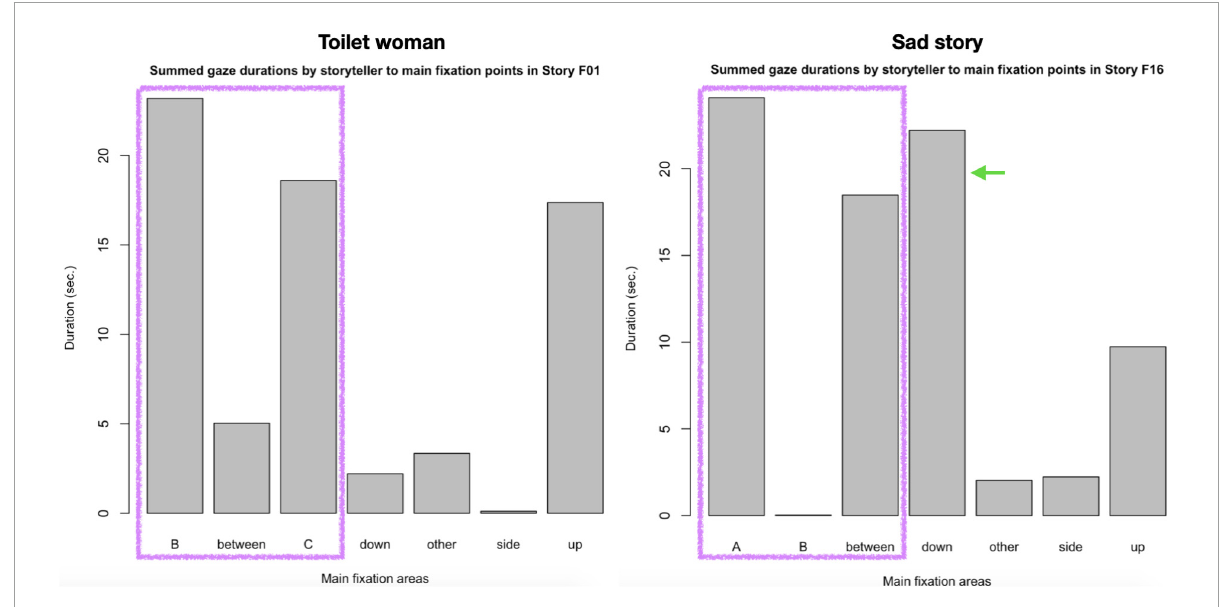
FIGURE7 Summed durations of main gaze